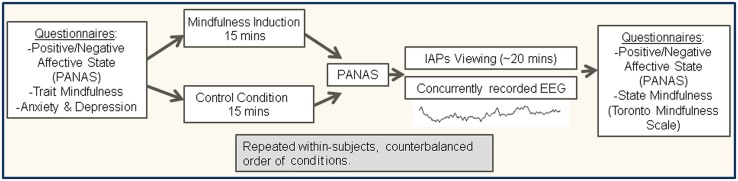
Overview of experimental procedure.